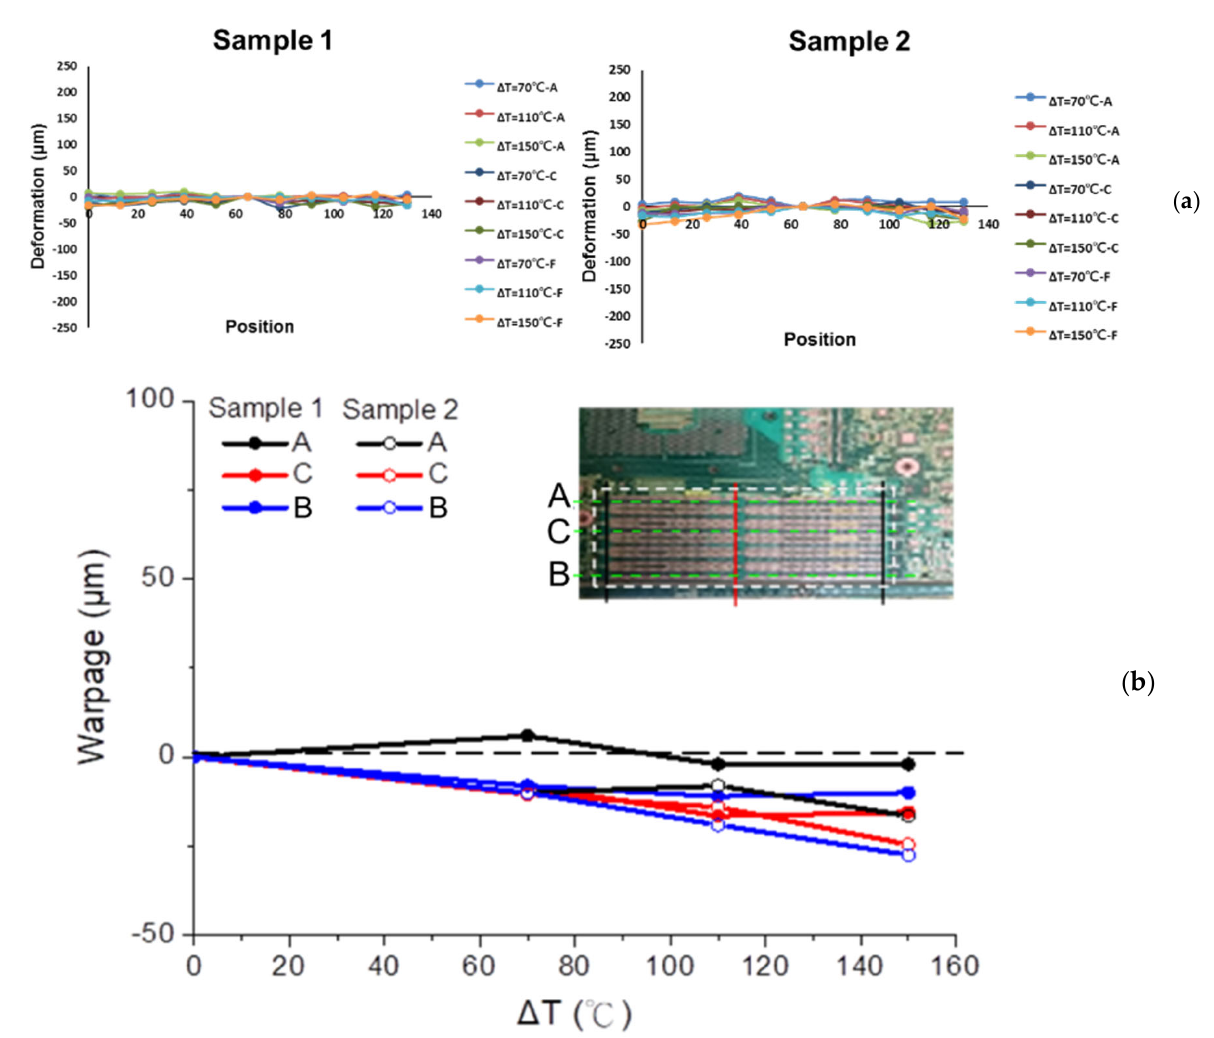
Figure 15. ( a ) Out-of-plane deformation contours (in do tt ed line box) for the bare PCB at various temperatures, obtained from moiré measurements, and ( b ) out-of-plane deformations of the bare PCB along three lines (A, B, and C) in which the sockets will be located.